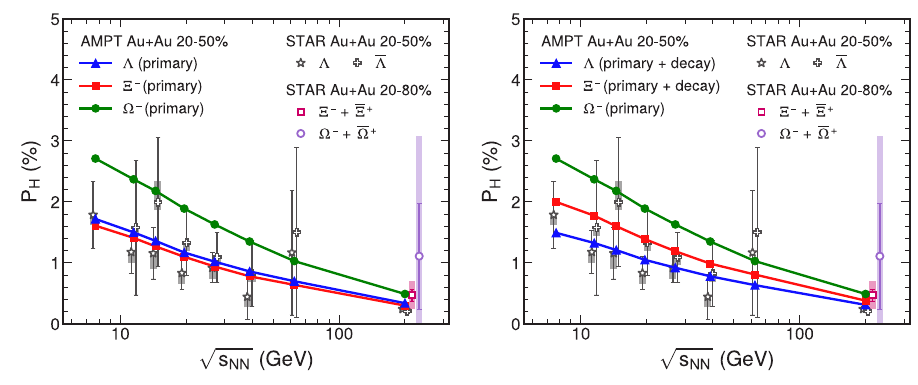
Figure 1. Global polarizations of Λ , Ξ − , and Ω − hyperons without (left) and with (right) the decay con- tributions to Λ and Ξ − taken into account. The STAR data [3, 4, 13] of inclusive hyperon polarizations are also shown for